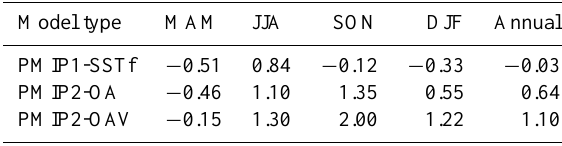
Table 2. Summary of seasonal changes in temperature ( ◦ C) av- eraged over high latitudes (60 ◦ N–90 ◦ N average) for the ensem- ble mean of nineteen PMIP1-SSTf simulations, thirteen PMIP2- OA simulations and five PMIP2-OAV simulations (The MRI- CGCM2.3.4nfa-OAV is